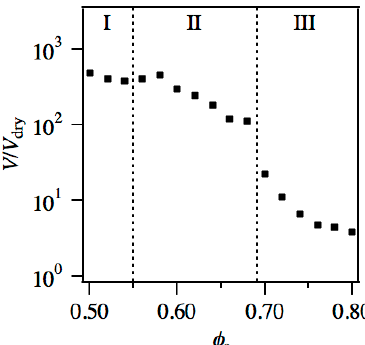
Figure 13. The degree of swelling V / V dry of the carboxylated SR gels as a function of φ a in shrinking process. From the SAXS profiles, the mesoscale structure of the SR gel can be classified into three regions (I–III).